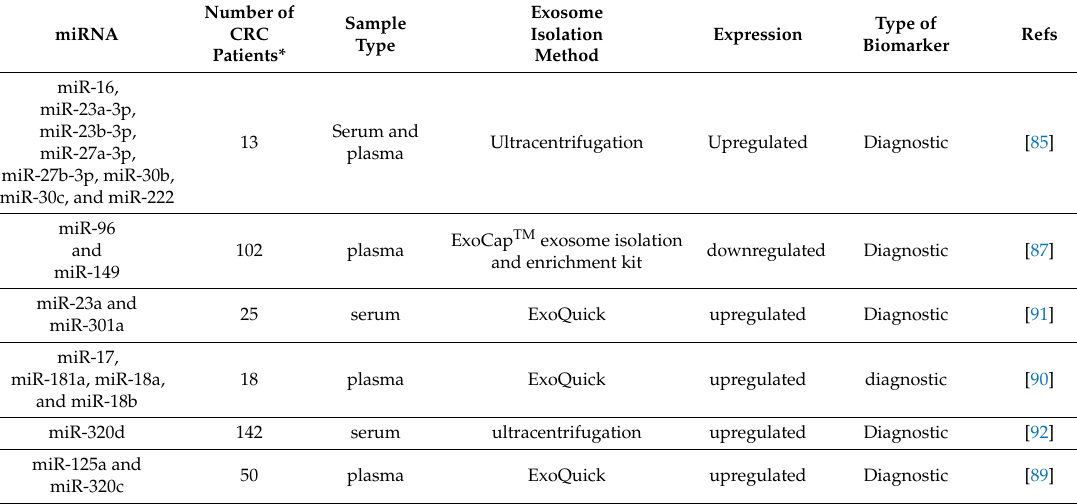
Table 1. Summary of exosomal miRNA studies in CRC